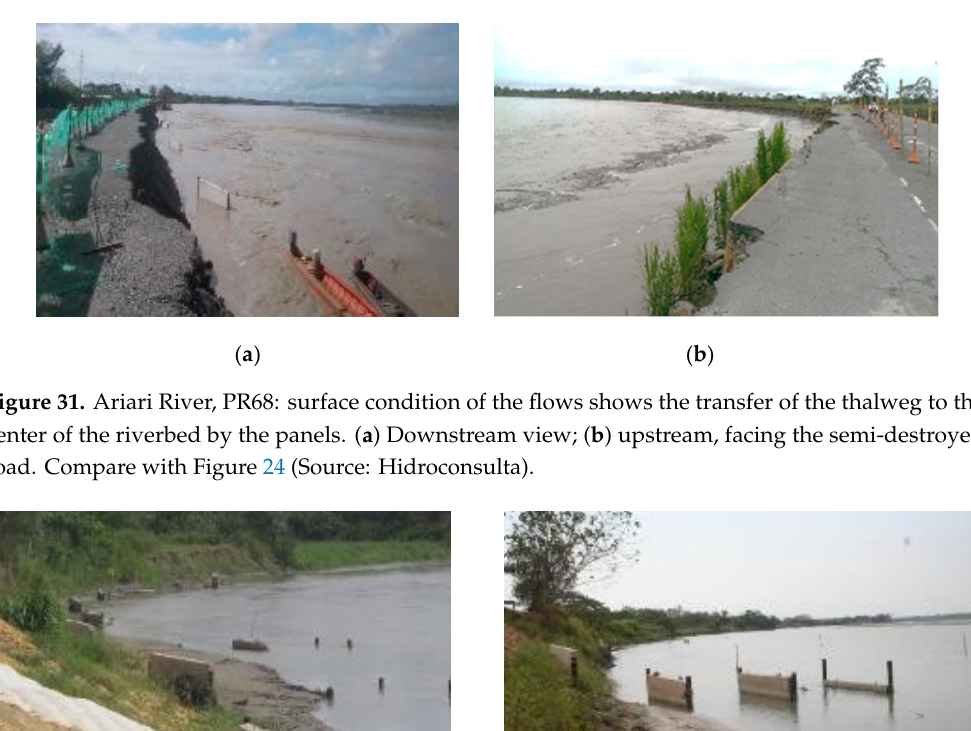
Figure 30. Ariari River, PR68: installation of vanes. ( a ) Positioning according to the design; ( b ) array in the process of installation.